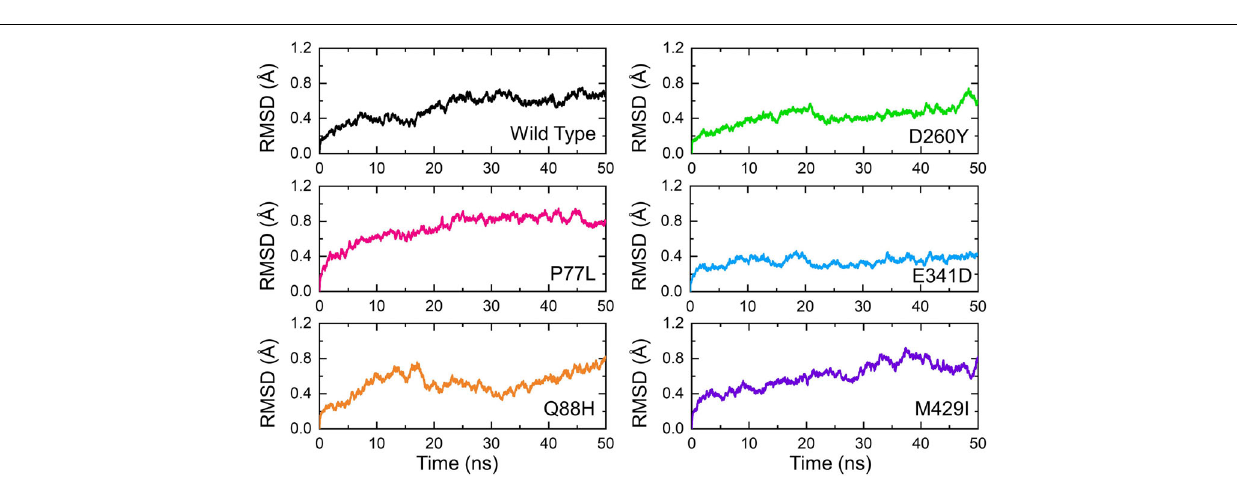
FIGURE 5 | Dynamic stability of the NSP13 WT and mutant complexes calculated as RMSD over the simulation time in nanoseconds. The RMSD of NSP13 WT is shown in black. For the mutants, the RMSDs are shown in different colors. RMSDs, root mean square